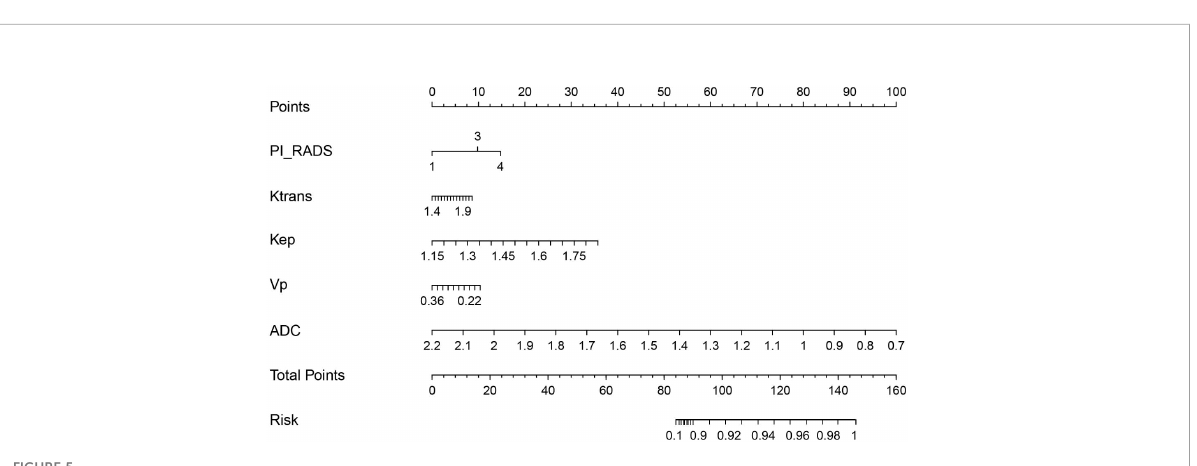
FIGURE 5 Nomogram for differentiating PCa from BPH. The nomogram was developed with PI-RADS, K trans , K ep , V p , and ADC. This nomogram can be used to classi fi cation of Pca from BPH. Before biopsy or surgery performed, patients underwent DCE-MRI and DWI scanning that, K trans , K ep , V p , ADC and PI-RADS were determined. All of these results will put into the Nomogram as follow: Points_PI_RADS will calculate by the score of Points which is vertically projected on the line of Points by PI-RADS. K trans , K ep , V p and ADC should be vertically projected on the line of Points to get Points_K trans , Points_K ep , Points_V p and Points_ADC. After this, the Total points is the sum of Points_PI_RADS, Points_K trans , Points_K ep , Points_V p and Points_ADC. After this, total points is vertically projected on the line of Risk for patients ’ probability of PCa.